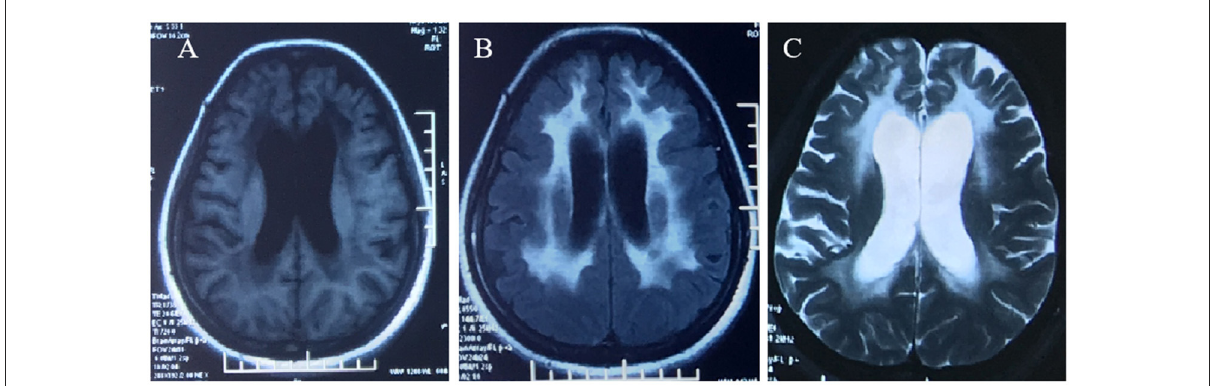
FIGURE1 Brain MRI demonstrated diffuse, symmetrical abnormal signal in the bilateral cerebral white matter, which was low signal in T1WI (A) , high signal in FLAIR (B) , and high signal in T2WI (C) .